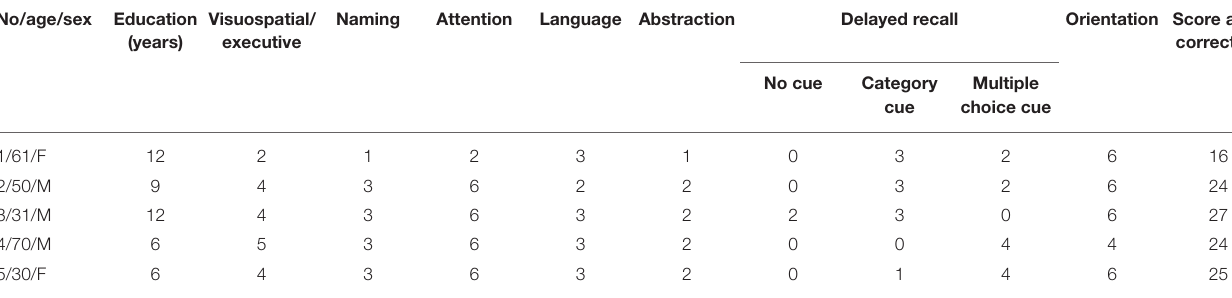
TABLE 3 | Montreal Cognitive Assessment scores of five patients.